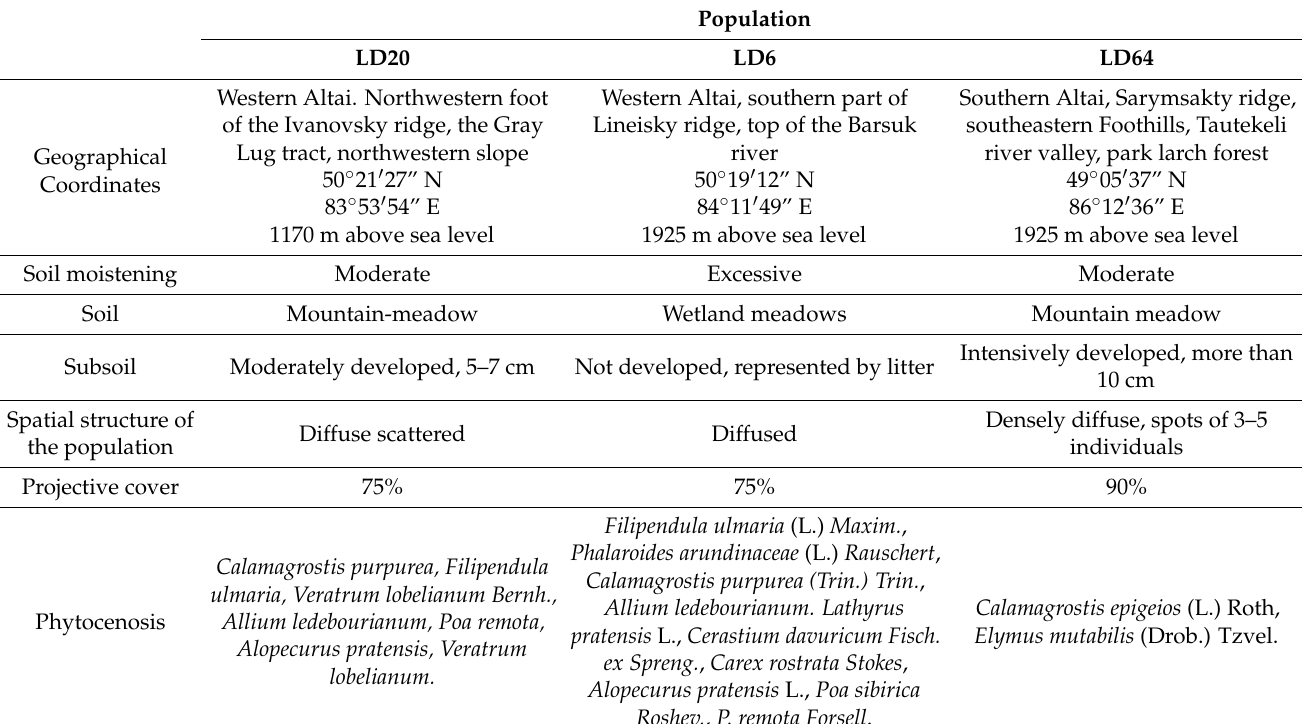
Table 2. Ecological and phytocenotic conditions of A. ledebourianum